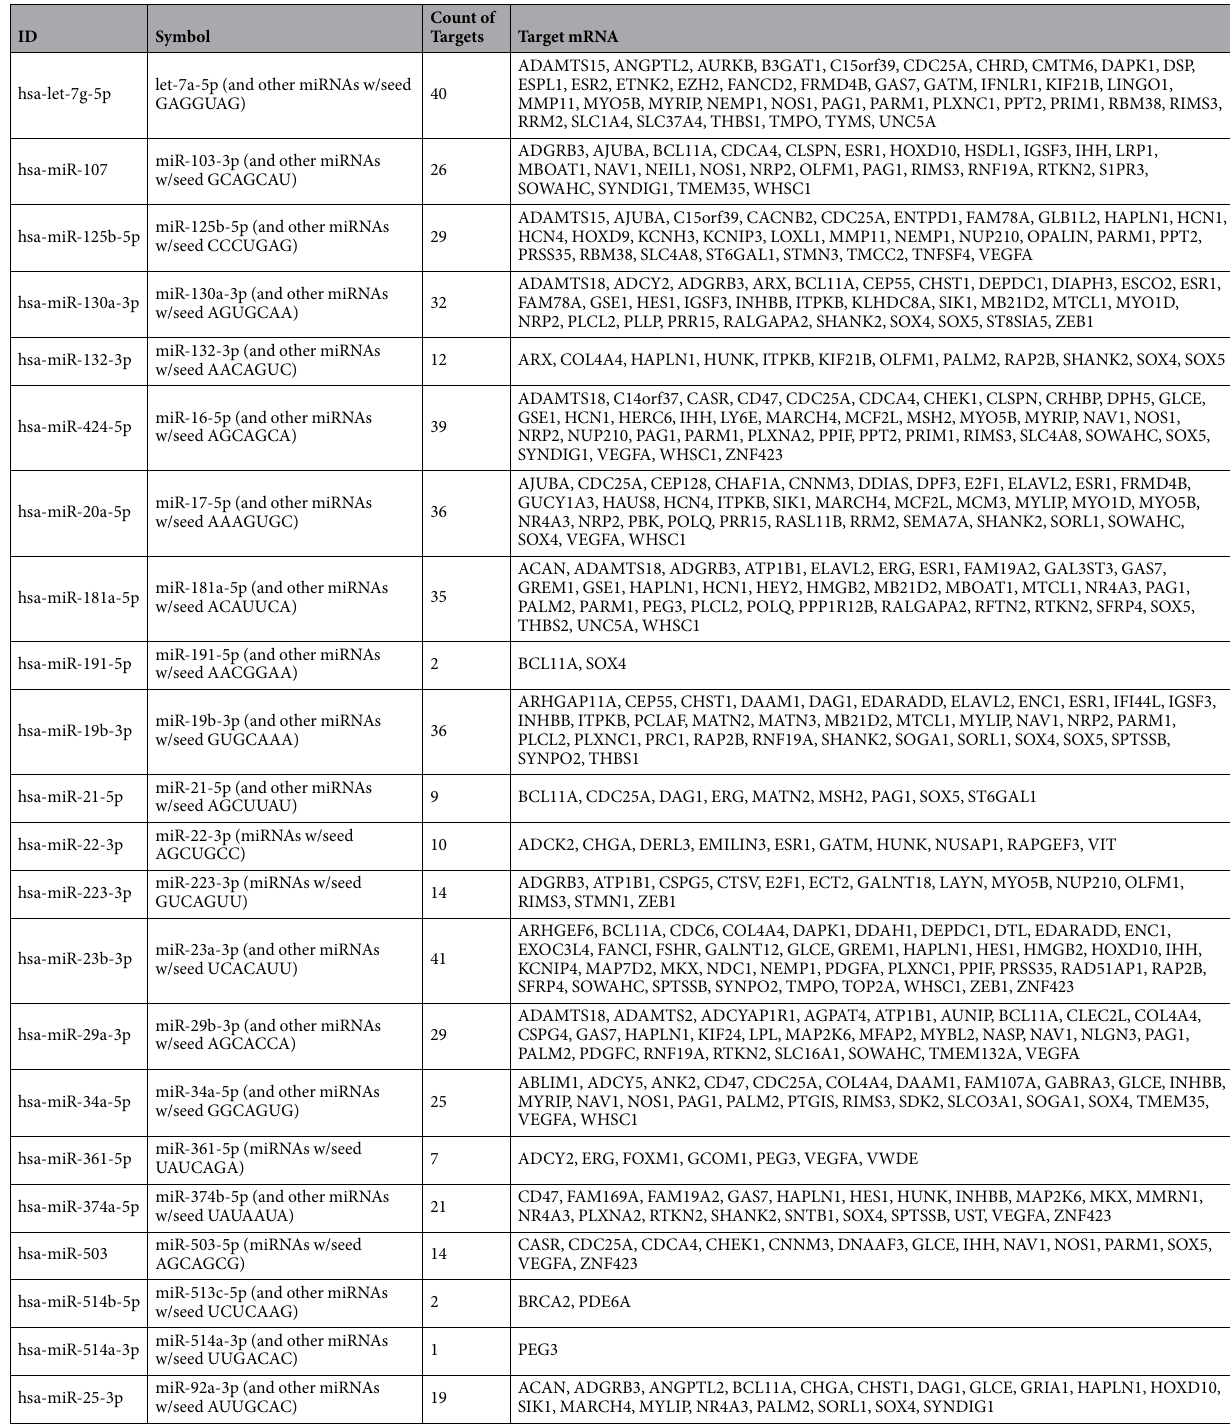
Table 2. The 234 miRNA target genes that negatively correlated with the expression of 22 differentially expressed